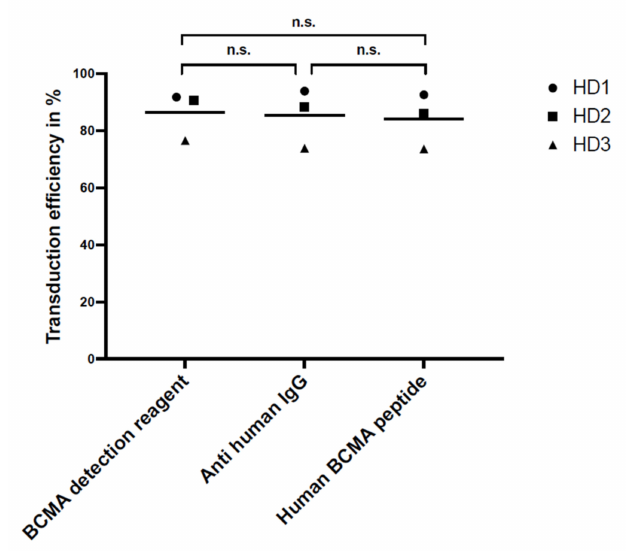
Figure 4. Sensitivity, i.e., transduction efficiency of CAR-T cells prepared from PBMCs of three different HDs using three different detection reagents measured by flow cytometry. There was no significant difference in sensitivity for the three reagents (n.s. > 0.05, no significance). The plot shows the mean values and statistical analysis with unpaired t